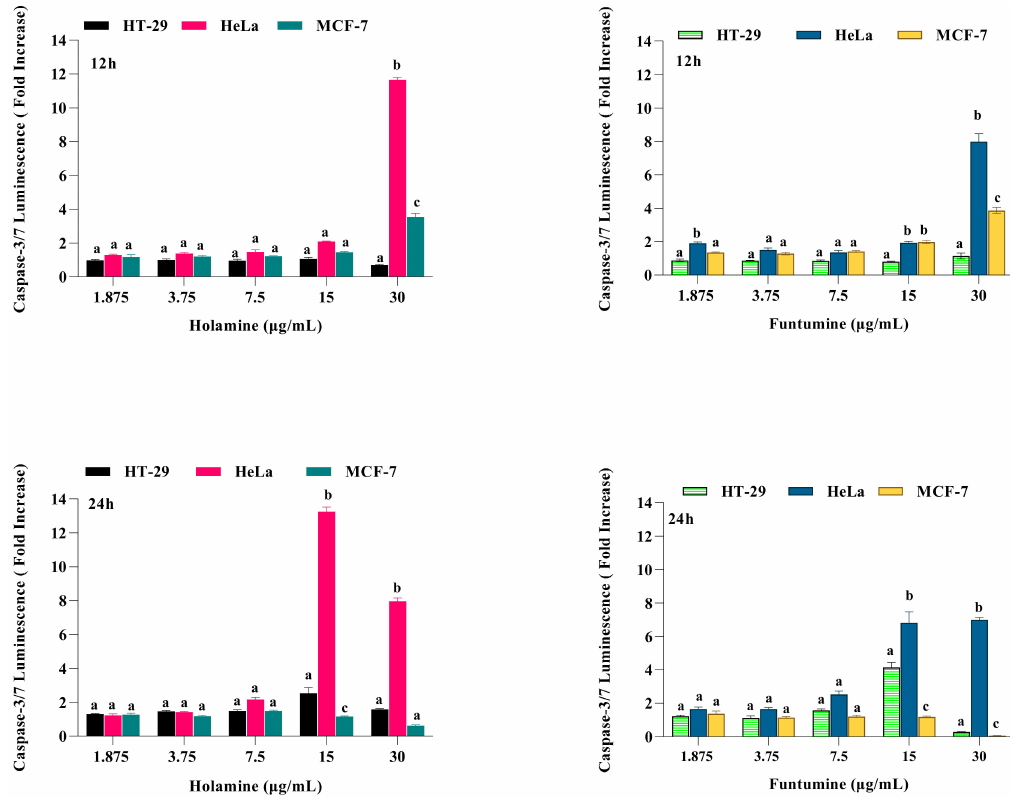
Figure 6. E ff ects of increasing concentrations of holamine and funtumine on the induction of caspase-3 / 7 activity in cancer cell lines (HT-29, HeLa and MCF-7) treated for 12 and 24 h, as indicated. Each bar represents the mean ± SEM of triplicate experiments. Bars that do not share a common alphabetic character di ff er significantly ( p <